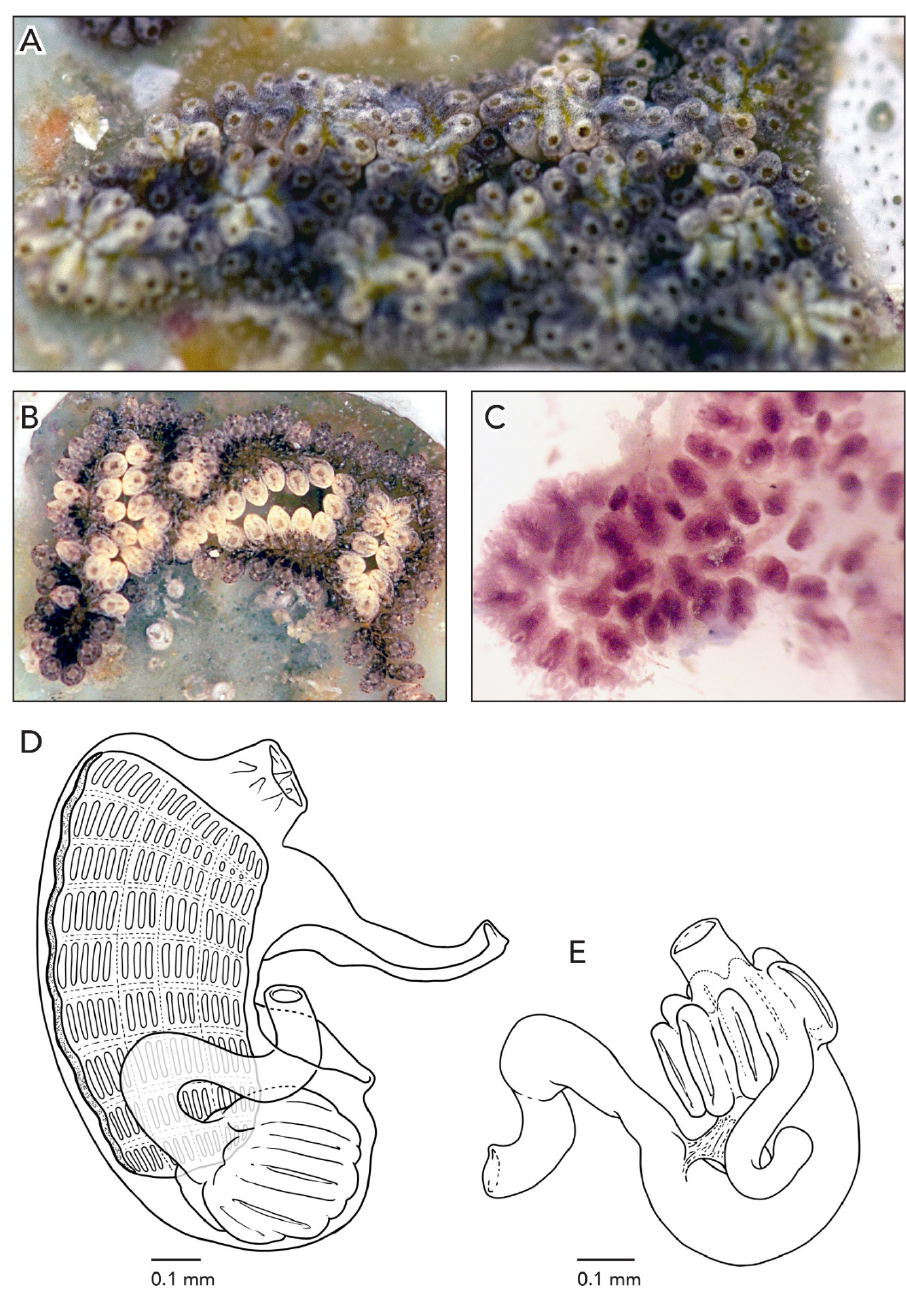
Figure 9. Botryllus tunnelli sp. nov. ( A , B ) Live colonies on the artificial substrate- (PVC) ( C ) Detail of a preserved colony ( D ) Left side view of zooid ( E ) Detail of the abdomen region.